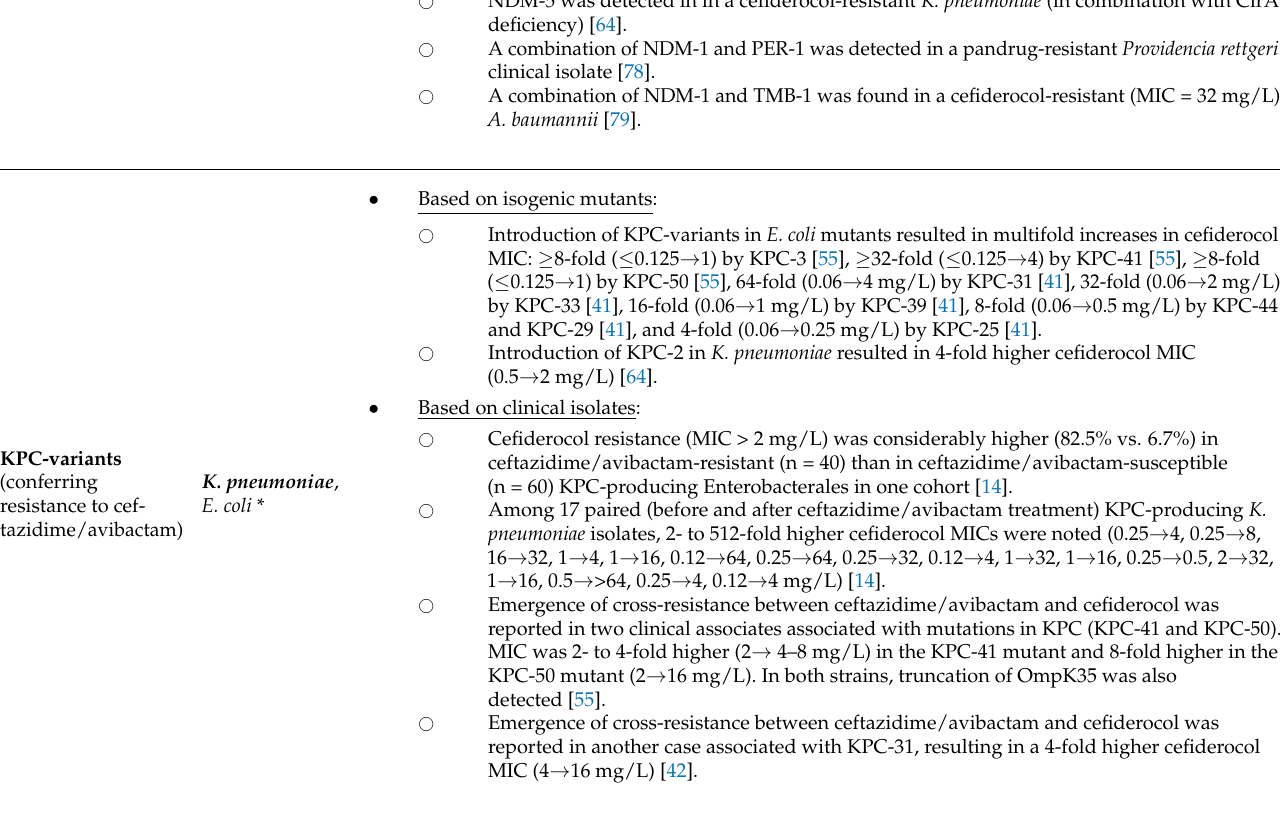
β -Lactamase Organism(s) Findings